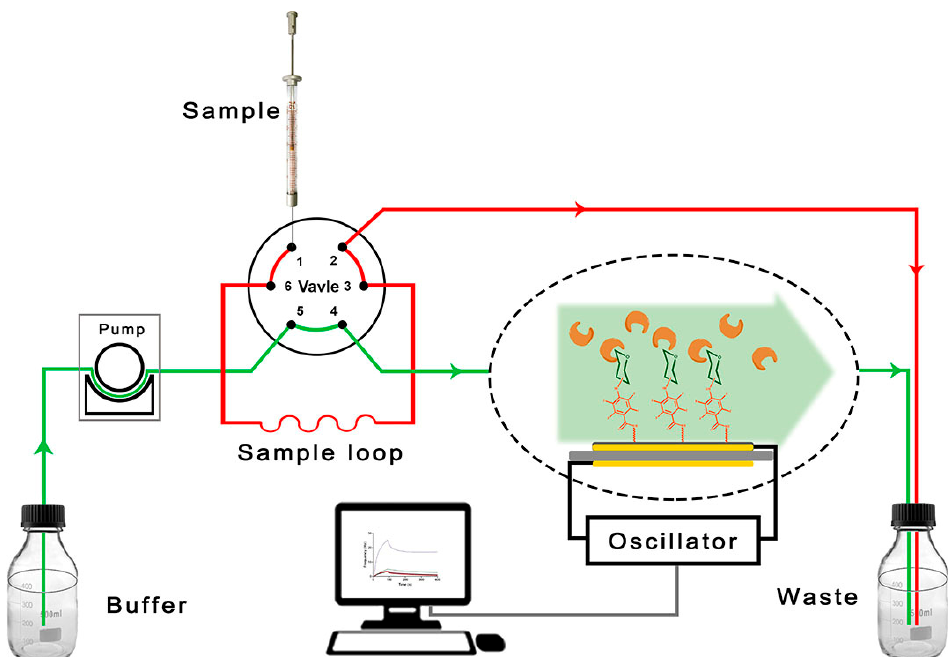
Figure 1. Scheme of the Attana quartz crystal microbalance (QCM) biosensor flow-through system.